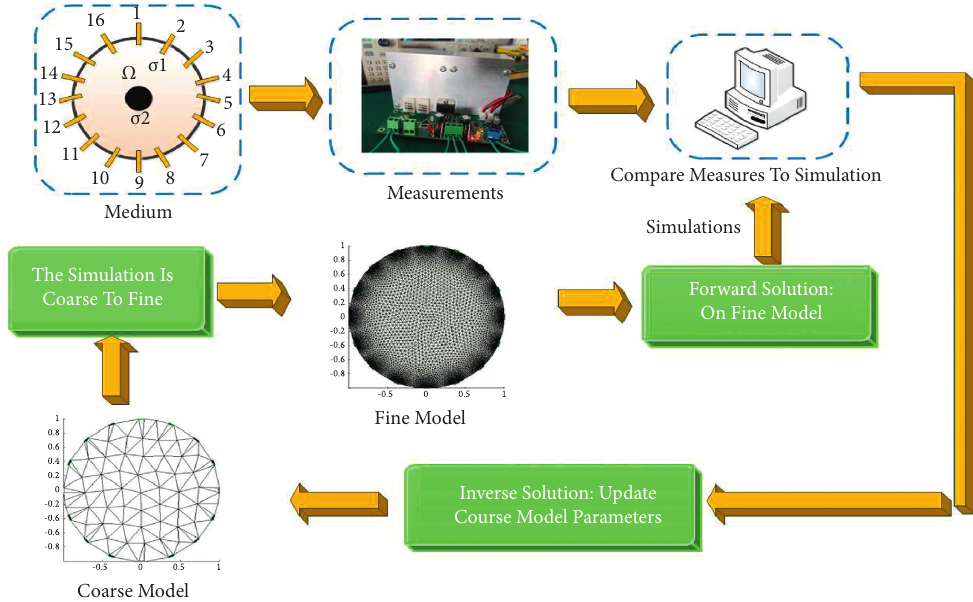
Figure 6: Schematic diagram for modeling the forward and reverse problems.